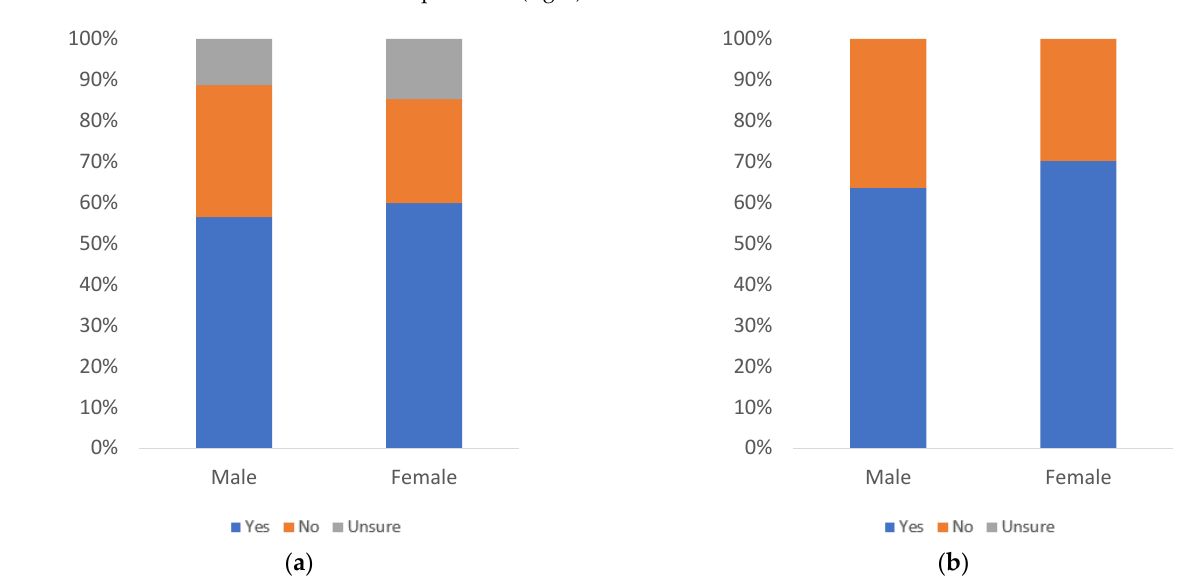
Figure 22. Label helpfulness, by education level: ( a ) with uncertain respondents (left) and ( b ) without uncertain respondents (right).